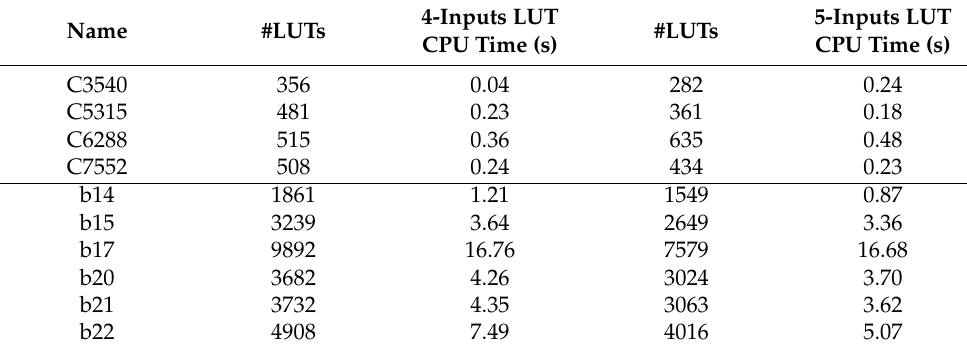
Table 2. Number of cells for two different implementations of the set of considered benchmarks featuring four and five-input LUTs,